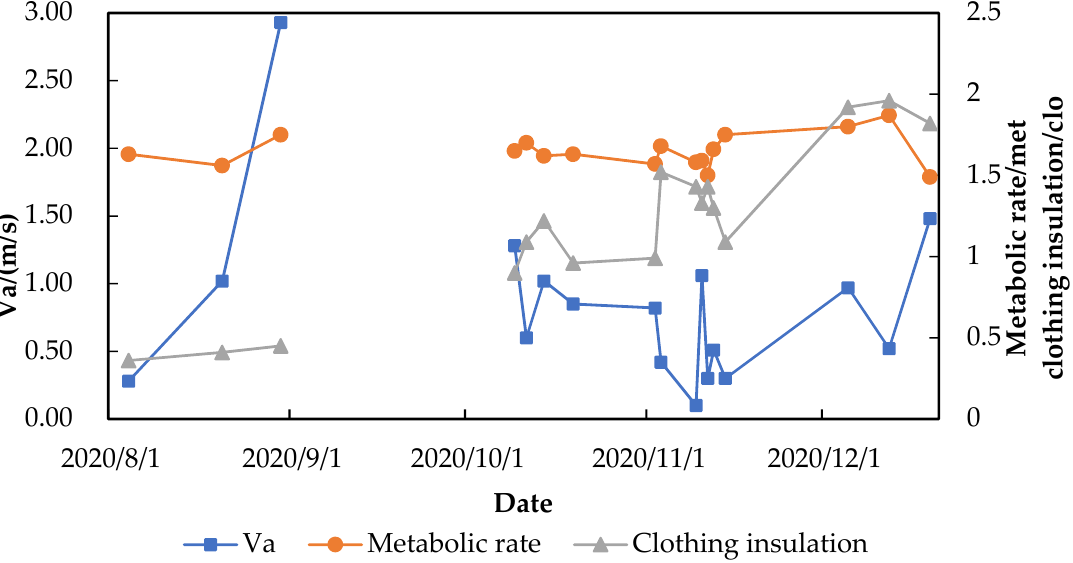
Figure 11. Metabolic rate, clothing insulation, and average wind speed at the lake side.